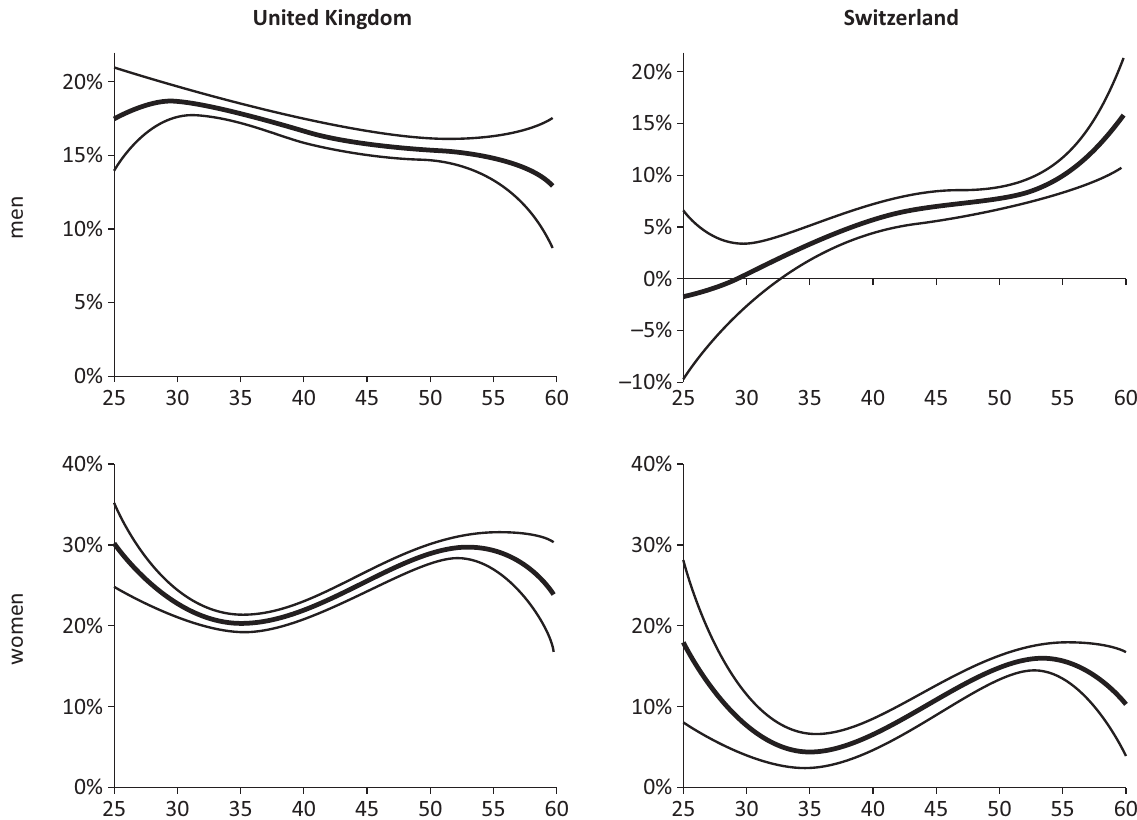
Figure 2. Difference in employment by age for upper-secondary vocational education relative to lower education (av- erage marginal effects). Source: UK Labour Force Survey 1993–2014 and Swiss Labour Force Survey 1991–2014, cohort 1954–1968. Note: Main line stands for average marginal effect; thinner lines stand for 95% confidence